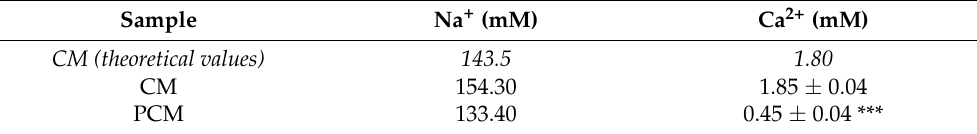
Table 1. Concentrations of sodium and calcium ions in culture medium (CM) and medium condi- tioned with the nHA paste (PCM). Values are the means ±SDs of triplicate samples (*** = p ≤ 0.0005). The theoretical concentrations of the two ions in the CM (according to the medium formulation) are also shown in italic